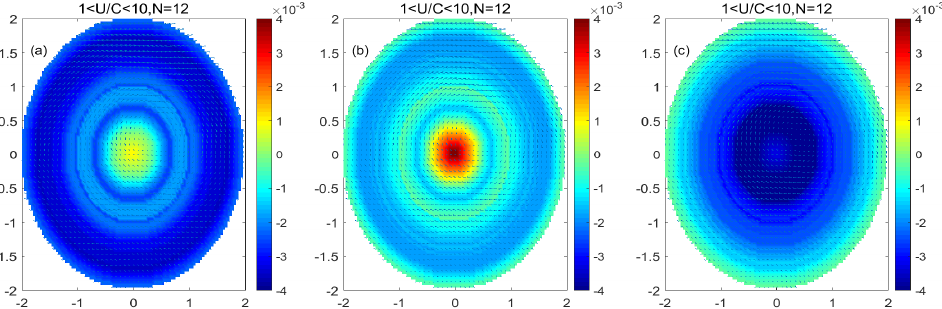
Figure 10. ( a − c ) are the monopole distribution of microplankton, nanophytoplankton, and picophy-